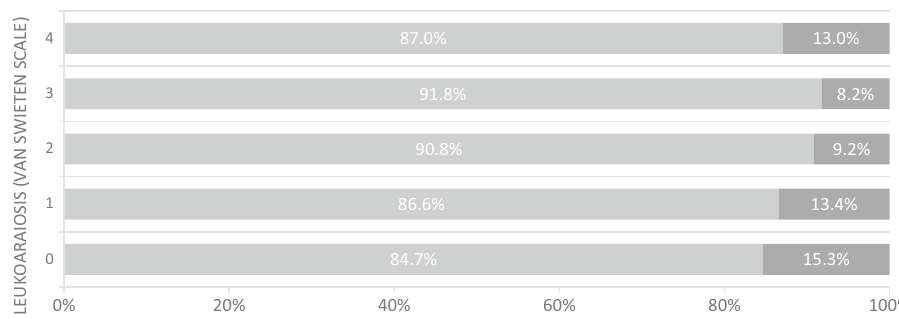
Figure 4. Occurrence of intracerebral hemorrhage depending on van Swieten Scale describing the degree of leukoaraiosis. sICH symptomatic intracerebral